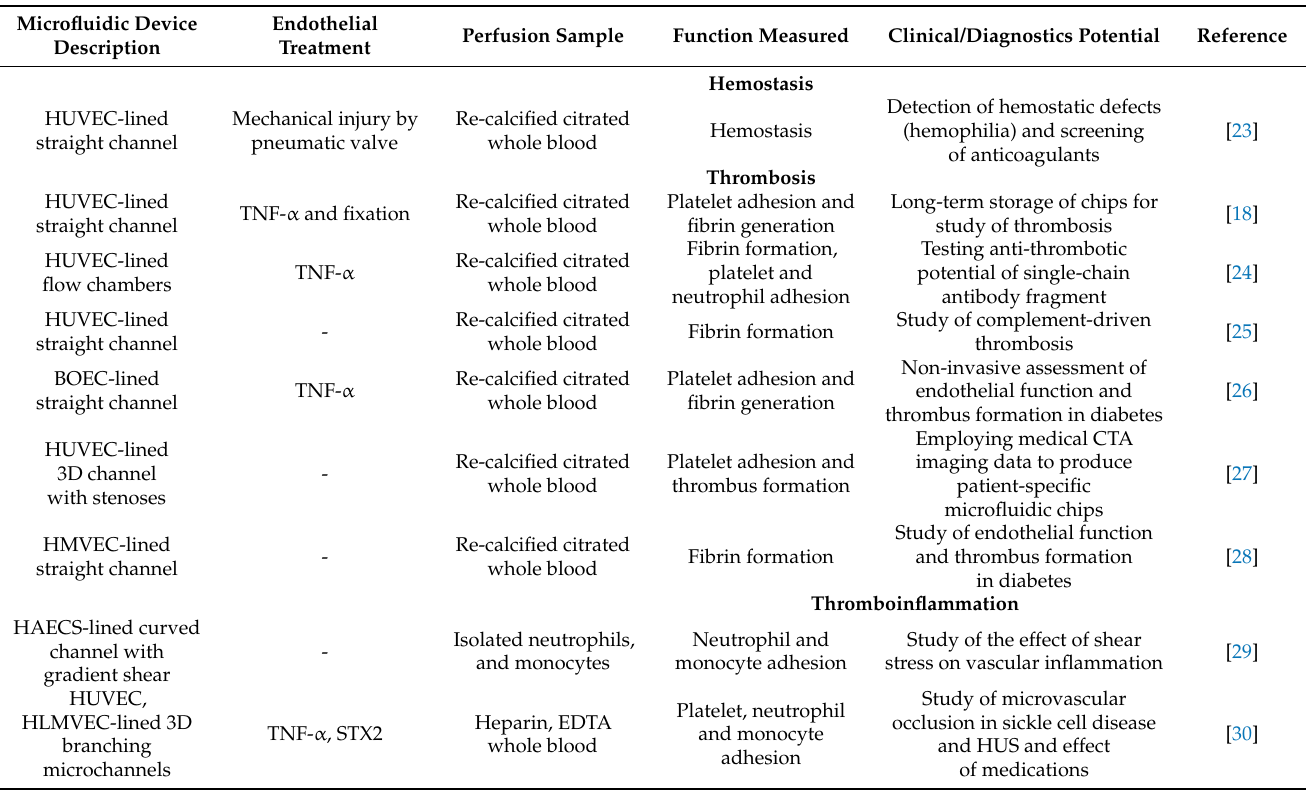
Table 1. Microfluidic endothelialised models used in basic and translational research for the study of vascular thromboin-